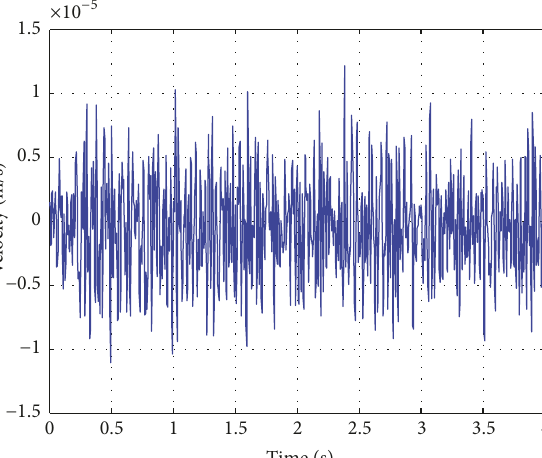
Figure 15: Transmissibility curves of experiment 1.